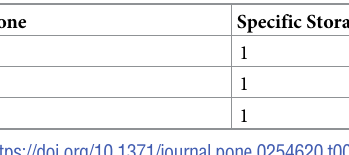
Table 2. Small-scale test case hydrologic properties.